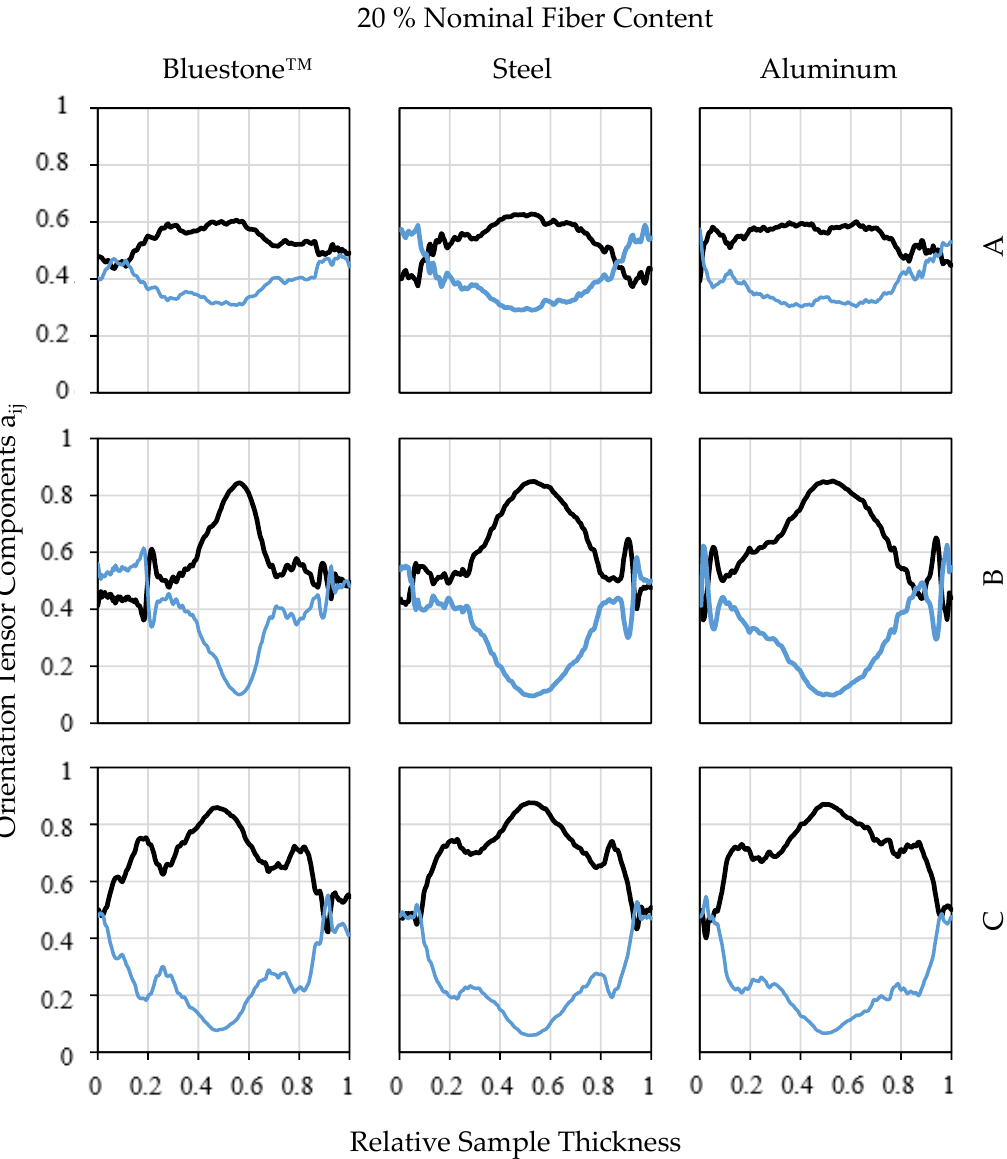
Figure A2. Orientation tensor components ( a 11 , a 22 ; without a 33 for better overview) and relative sample thickness for a nominal fiber content of 20 wt.%. Specimens were created with Bluestone, steel, and aluminum tools, with samples from regions A, B, and C (in accordance with Figure 9).